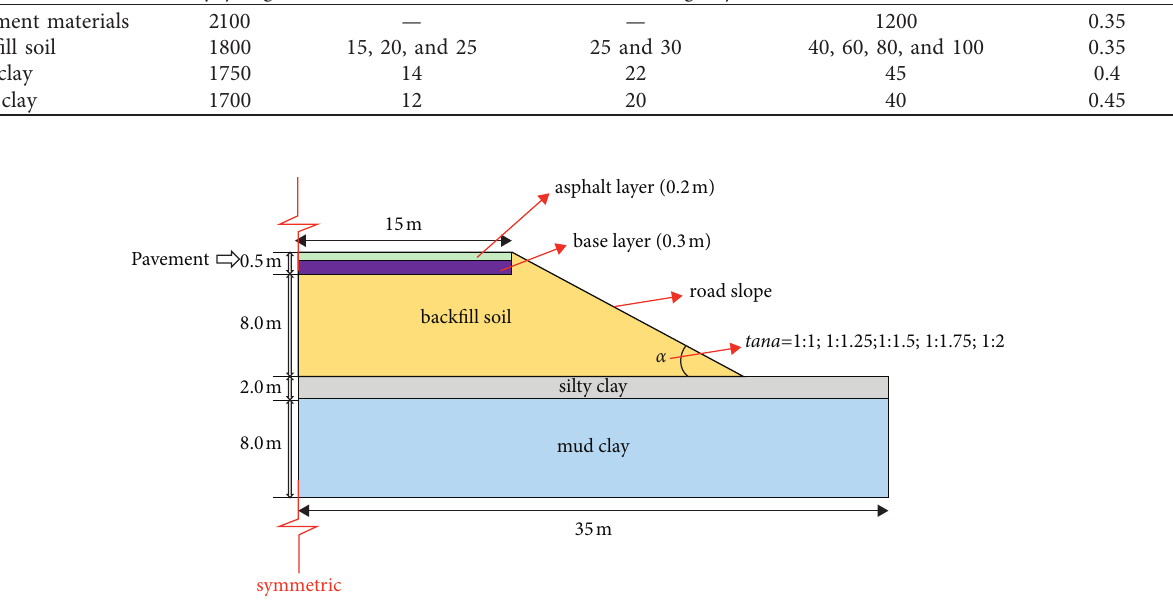
Figure 2: High-filled road with the backfill